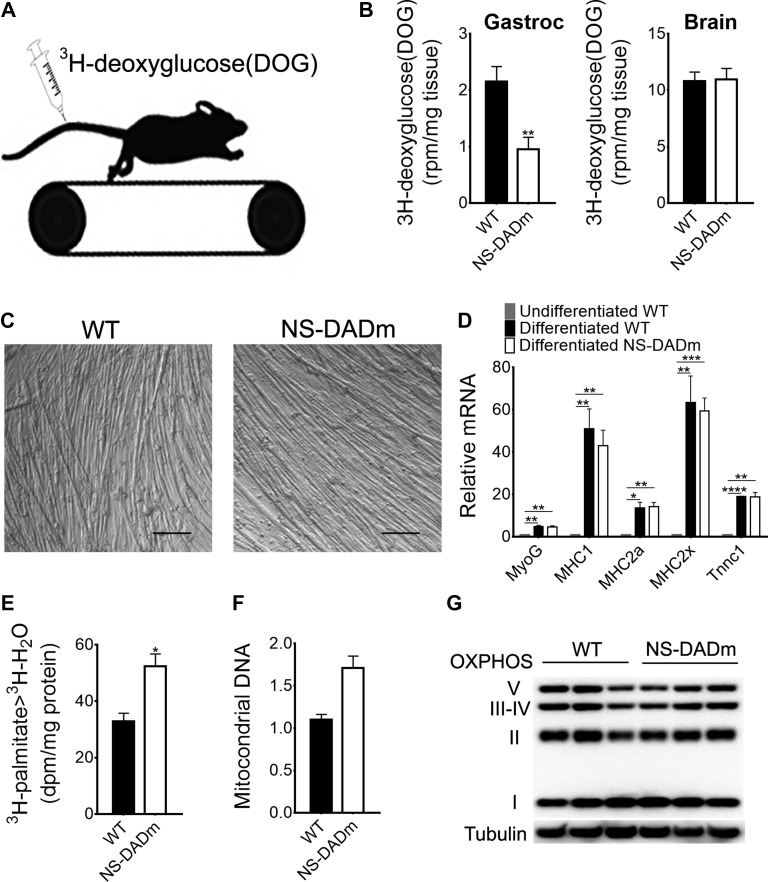
Altered fuel metabolism in NS-DADm muscles. (A) Mice were injected with 3H-deoxyglucose (DOG) through tail vein immediately before treadmill running. (B) Tissue-specific DOG uptake in gastrocnemius (gastroc) muscles and brains of 4-month old mice (n = 5 mice). (C) Representative images of differentiated myotubes from isolated primary myoblasts. (D) RT-qPCR analysis of differentiation markers (n = 3 wells of cells). (E) Fatty acid oxidation in primary myotubes (n = 3 wells of cells). (F) Mitochondrial DNA quantification by qPCR in whole-genome extraction of TA muscles. Mitochondrial gene (mtND1) was normalized to a nuclear gene Ndufv1 (n = 4 mice). (G) Western blot analysis of mitochondrial OXPHOS complexes in TA muscles of 5-month-old mice (n = 3 mice). Data are presented as mean ± SEM. *P < 0.05, **P < 0.01, ***P < 0.001, ****P < 0.0001 between genotypes by unpaired t-test.